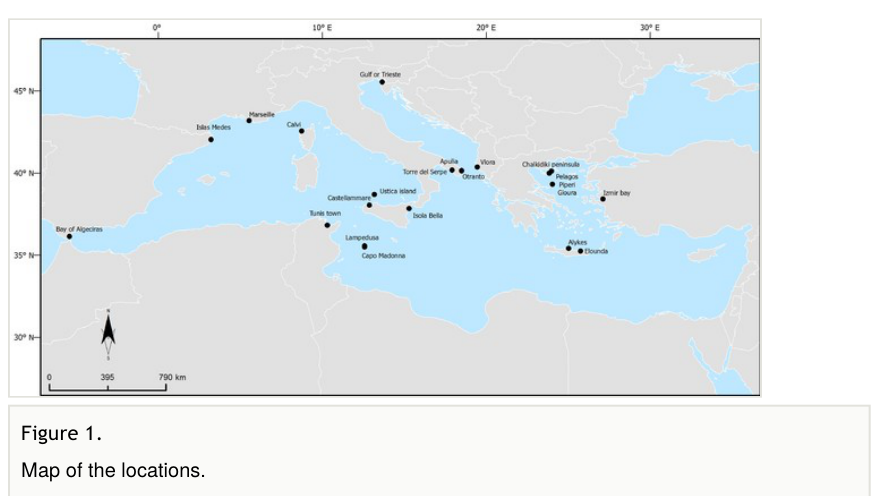
Figure 1. М ap of the